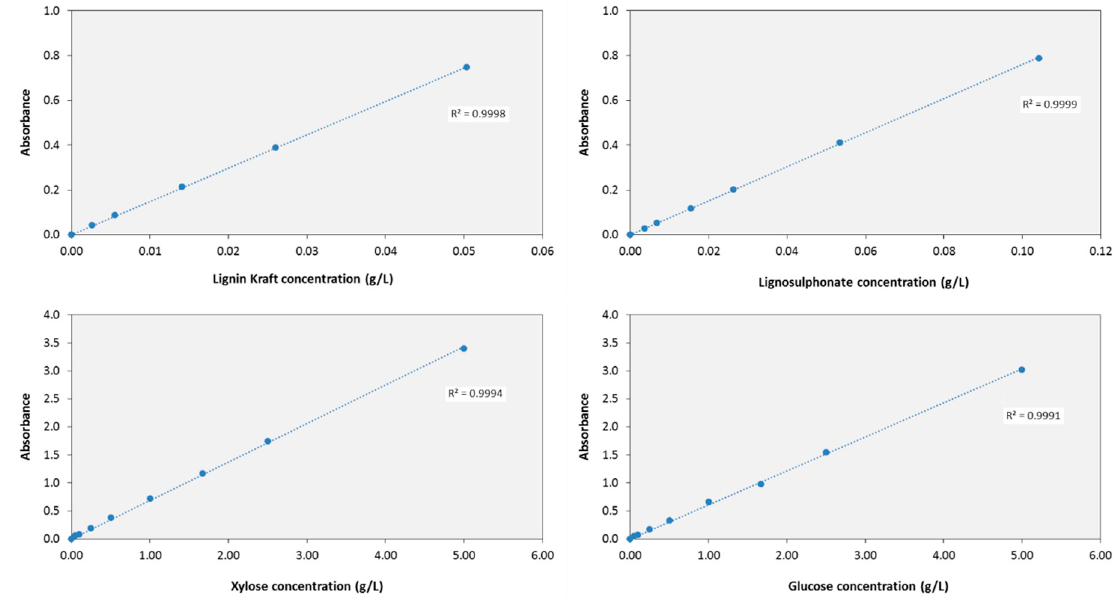
Figure 5. Calibration curves for the determination by ultraviolet–visible (UV-VIS) spectrophotometry of the concentration of the different tested solutes.